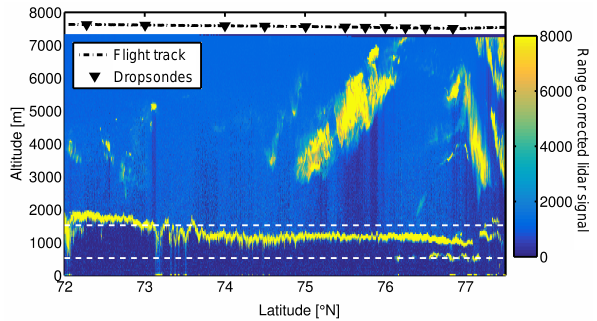
Figure 2. Lidar signal from section 1 of the flight. Aircraft alti- tude is indicated (black) and each dropsonde release point is marked (downward-facing triangles). White dotted lines are shown at 500 and 1500m to ease comparison with the in situ